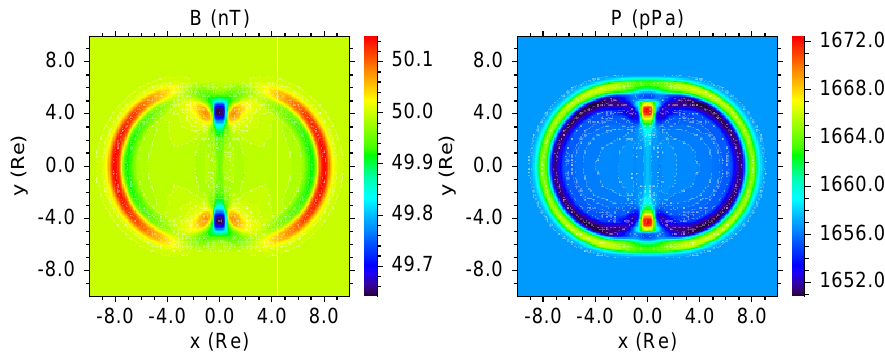
Fig. 5. Results of the slow mode wave test simulation with a small pressure disturbance in the center of the box. The same simulation algorithm and similar grid size are used in this simulation as those in the global simulation in the magnetosheath. Typical magnetosheath values are used to set the uniform background with magnetic field in the y-direction.